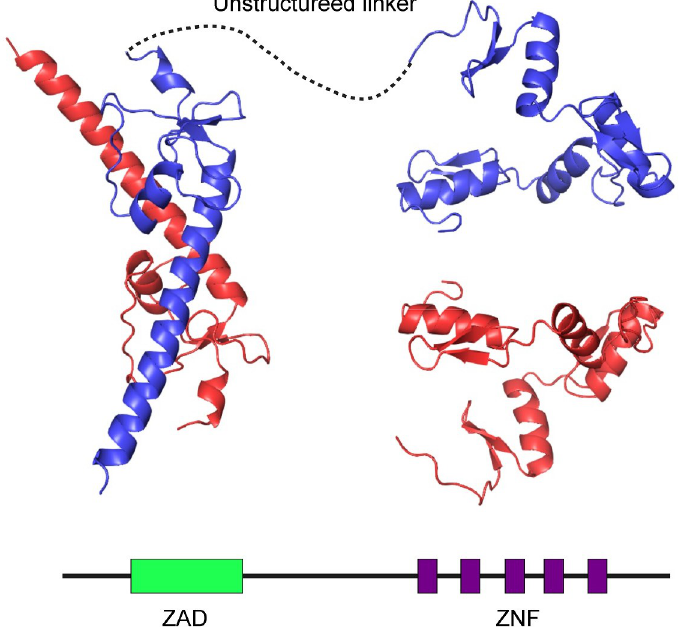
Fig 1. Predicted structure of Cucoid. Structure of a Cucoid homodimer (maternal isoform from C . quinquefasciatus , GenBank: QFQ59549.1) as predicted by AlphaFold2 (AlphaFold identifier for Cucoid structure: A0A5P8HWN4) is shown with the two chains colored in red and blue above a simplified sketch of full-length Cucoid protein with the N- terminal end to the left and the C-terminal end to the right, and ZAD and ZNFs marked by colored rectangles.